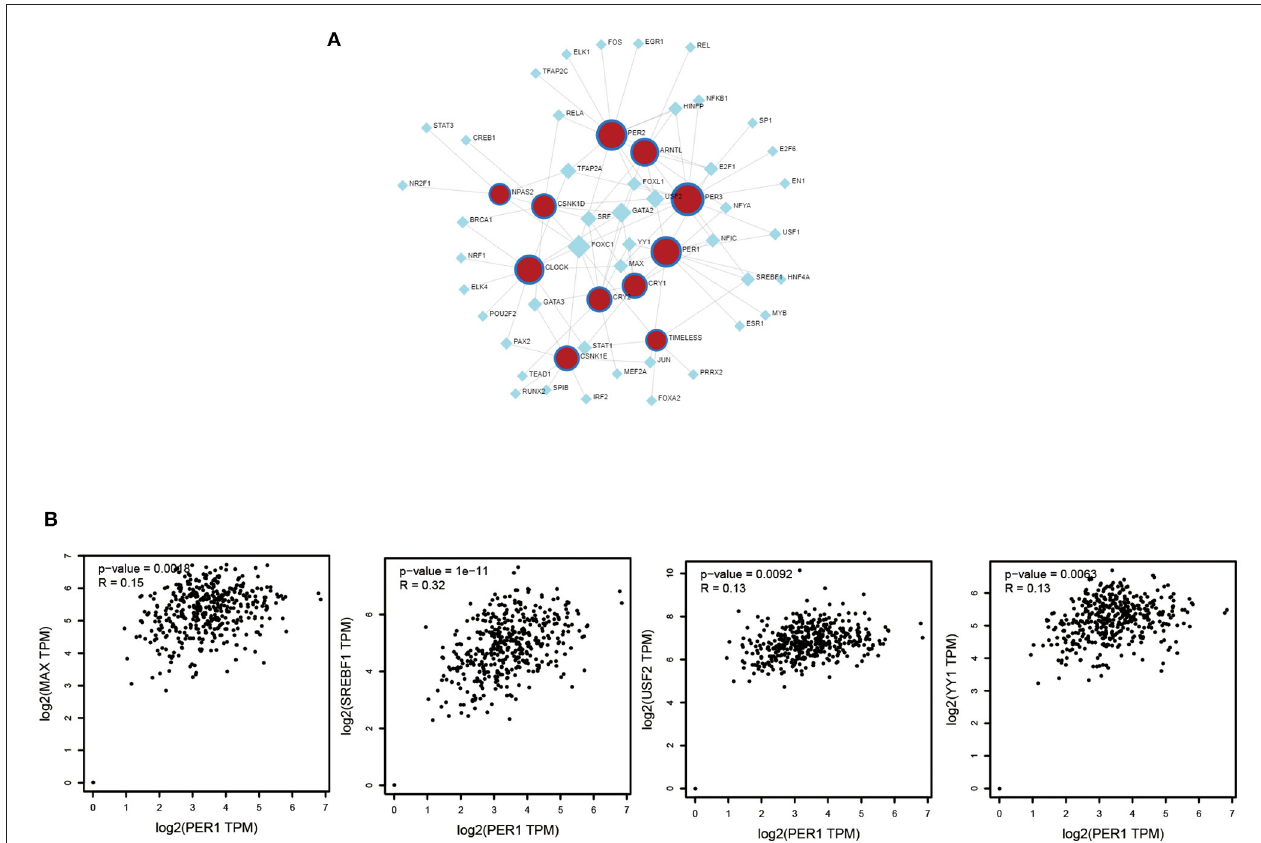
FIGURE 5 | Associations of TFs and PER1-interacting genes (ARNTL, CLOCK, CRY1, CRY2, CSNK1D, CSNK1E, NPAS2, and PER3). (A) Network of TFs and selected PER1-interacting genes. (B) Correlation between TFs and PER1 expression.